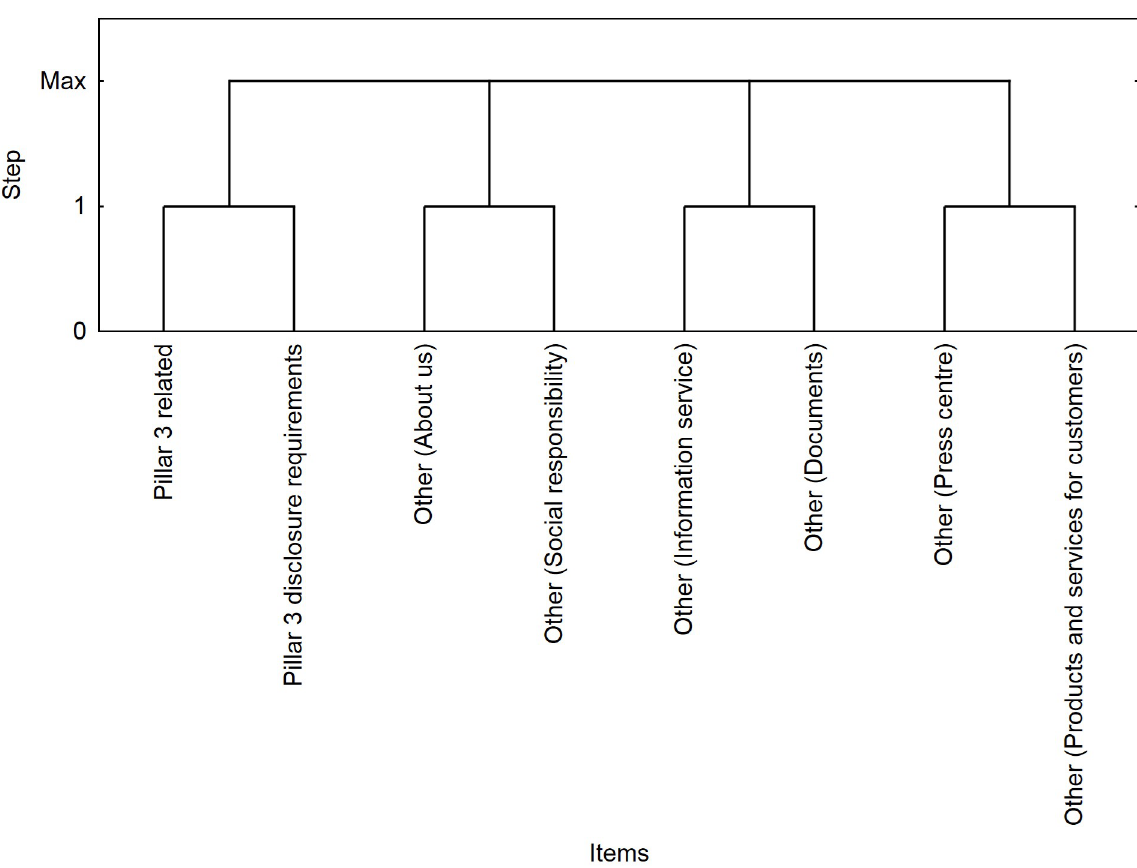
Fig 9. Visualization of segments in the fourth